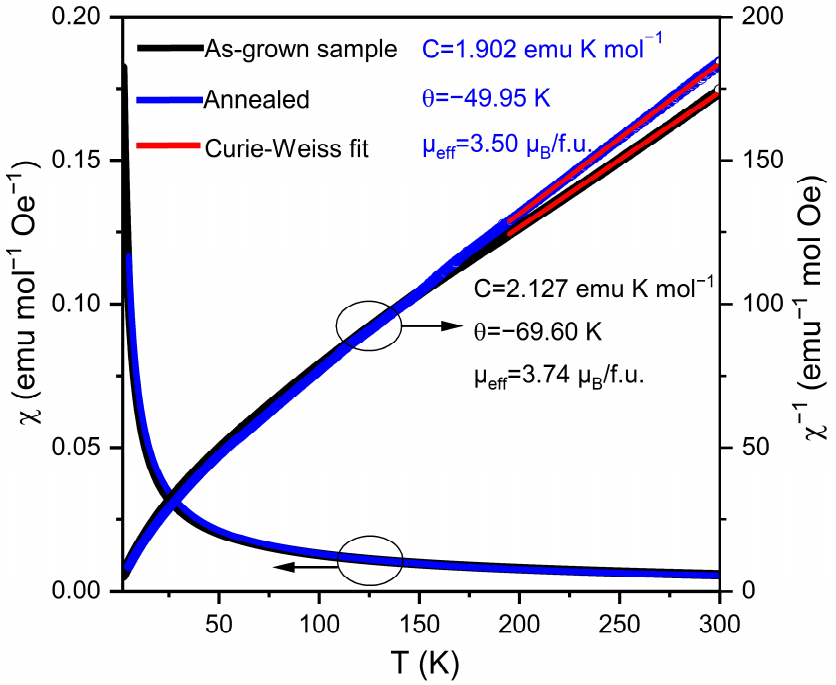
Figure 5. DC susceptibility χ (left) and inverse magnetic susceptibility 1/ χ (right) for as-grown NdNiO 3 , and NdNiO 3 annealed at 650 °C for 48 h under pO 2 = 280 bar. The symbols are the experimental data and the red lines are the Curie–Weiss fit.